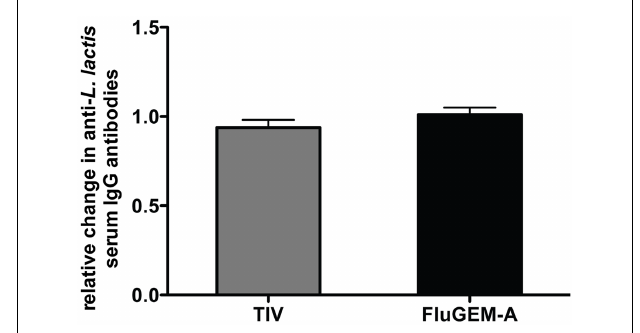
FIGURE 6 | Relative change in BLP-specific antibody titer after i.n. vaccination with FluGEM-A . Blood samples were collected from all test subjects and L. lactis -specific antibody titers were determined on study days 0 (baseline titers) and 42. In both vaccination groups (i.m.TIV and i.n. FluGEM-A) no increase in L. lactis -specific antibody titers due to vaccination were measured.